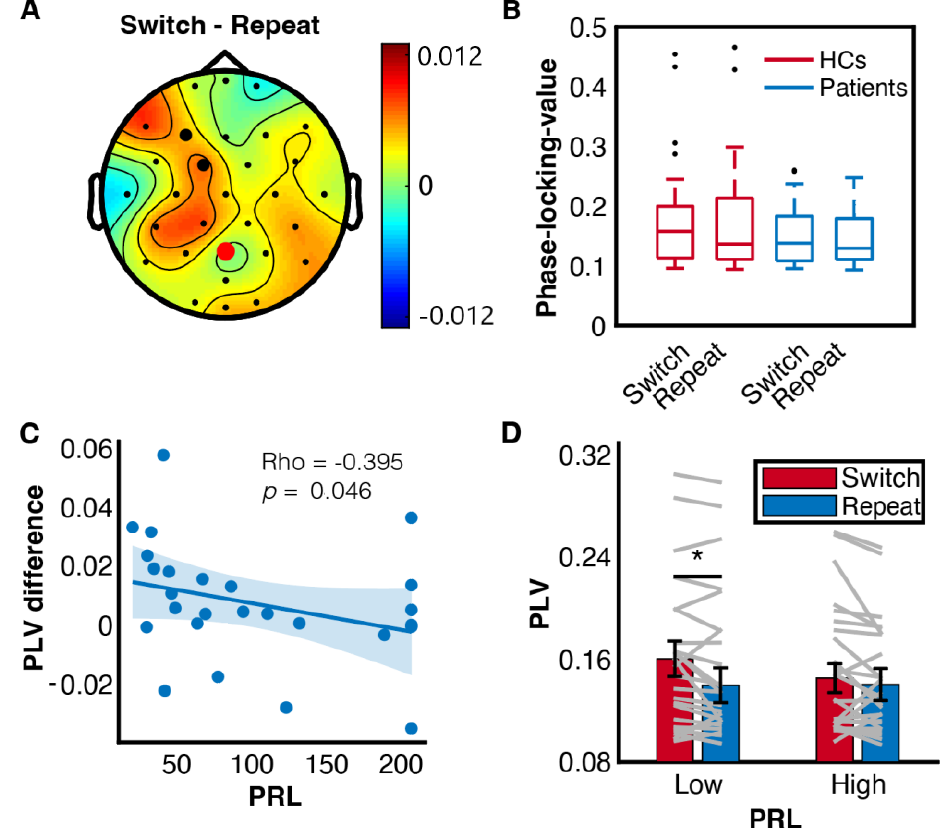
Figure 5. Frontoparietal connectivity at theta band. ( A ) topography of PLV referenced at Pz. FC1 and F3 were selected for frontoparietal phase synchrony analysis. ( B ) Boxplot of PLV in each condition. Central lines indicate the median, and the bottom and top edges of the box indicate the 25th and 75th percentiles. Black dots represent outliers. ( C ) Spearman rank correlation of PRL and PLV difference between switch and repeat trials. Coloured dots represent individuals. ( D ) Frontoparietal connectivity of patients subgrouped by PRL. * p < 0.05.